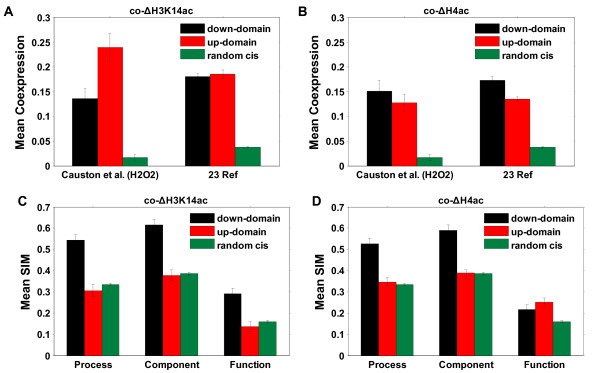
The coexpression and co-function of gene pairs in up-domains and down-domains. (A) Mean coexpression of gene pairs in co-ΔH3K14ac up-domains (red), down-domains (black) and random cis-pairs (green). (B) Mean coexpression of gene pairs in co-ΔH4ac up-domains (red), down-domains (black) and random cis-pairs (green). (C) Mean SIM of gene pairs in co-ΔH3K14ac up-domains (red), and down-domains (black) and random cis-pairs (green). (D) Mean SIM of gene pairs in co-ΔH4ac up-domains (red) and down-domains (black) and random cis-pairs (green).